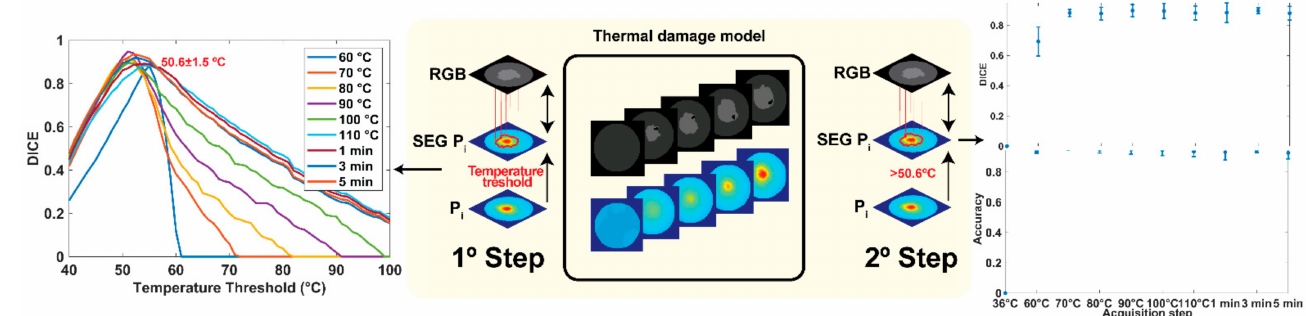
Figure A1. Schematic of the analysis performed and metrics calculated to validate peak temperature maps as a thermal damage